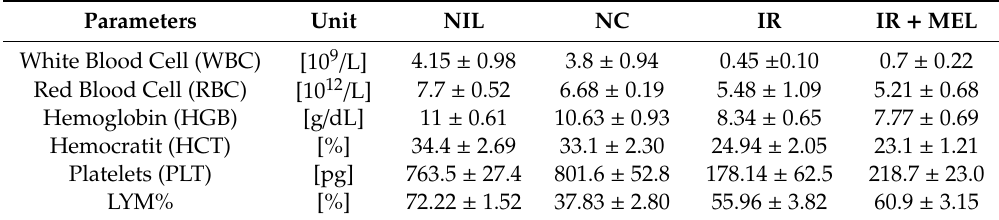
Table 2. Lab results for hematological analysis.